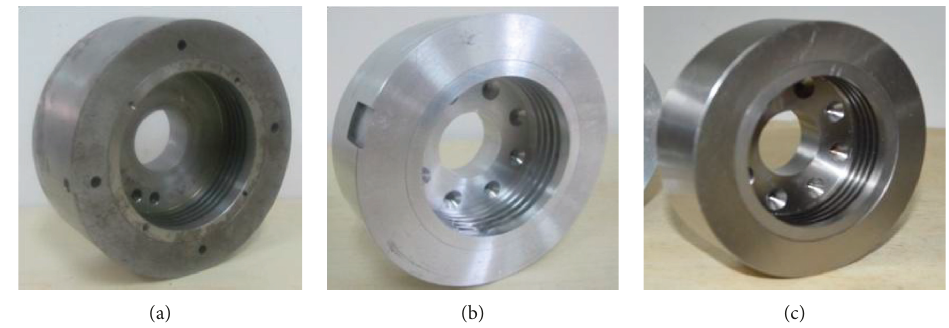
Figure 12: Assembled balance terminal. (a) Steel-45#. (b) Aluminum alloy-7A04. (c) Titanium